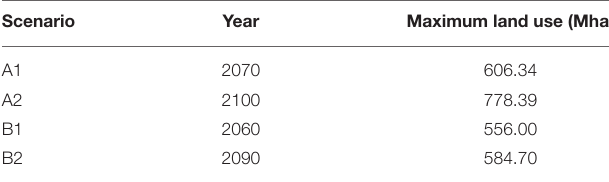
TABLE 4 | Maximum land use and the corresponding year in each